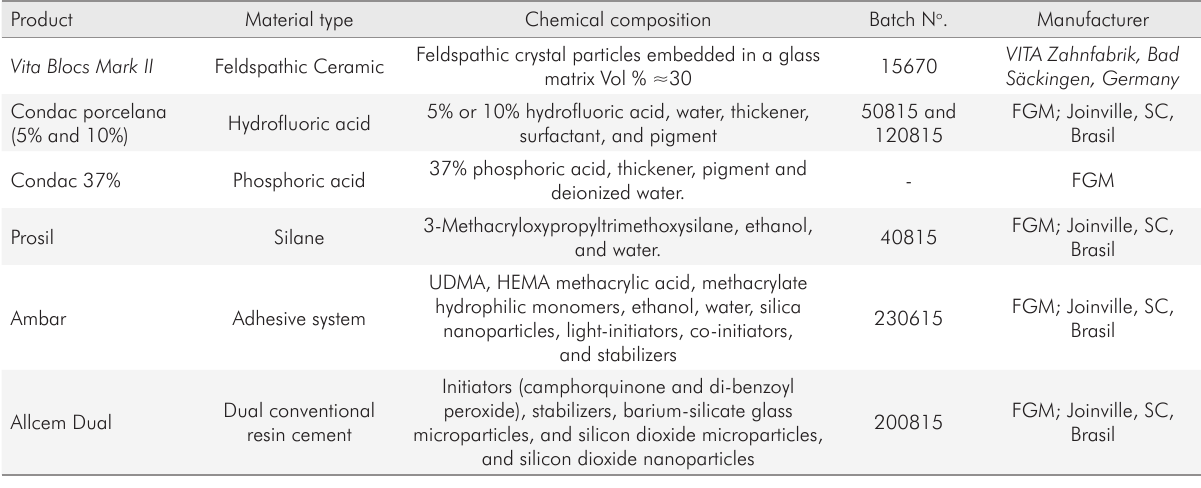
Table 1. Information of the materials used in this study.